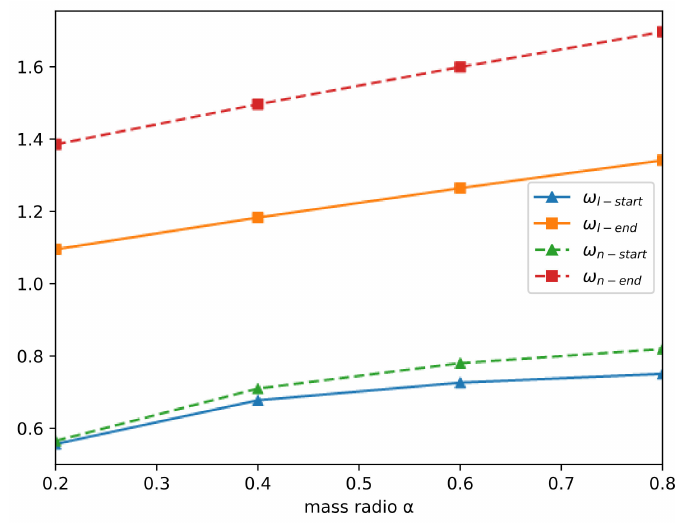
Figure 6. Effect of mass ratio on starting and ending frequency.